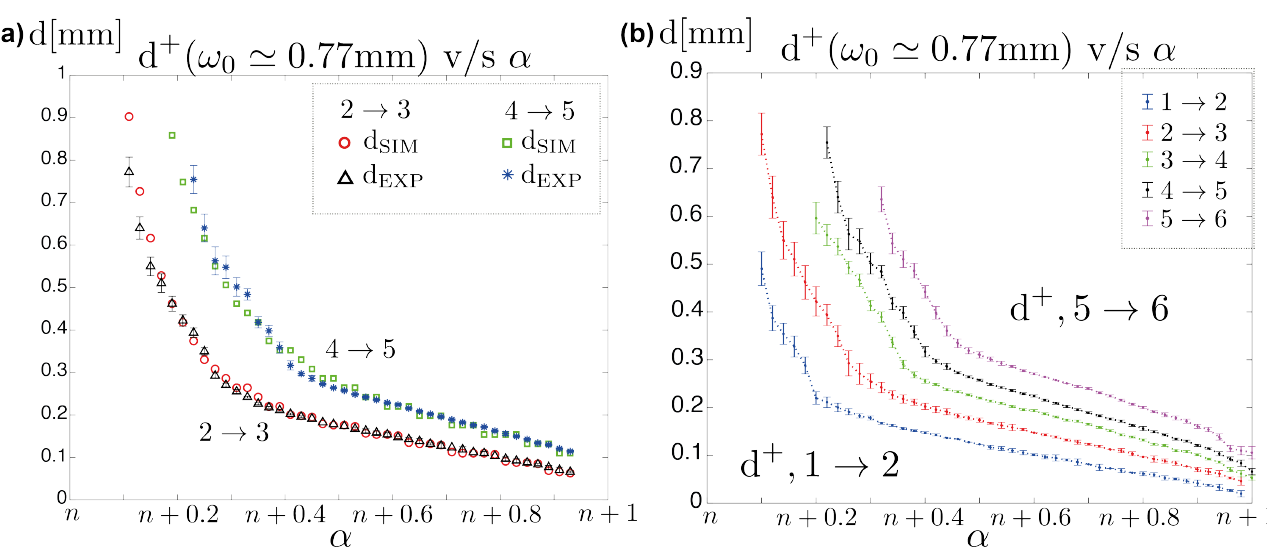
Figure 5. ( a ) Distances of resident vortices v r ( ω 0 = 0.77 mm, λ = 632.8 nm), for phase transitions 2 → 3 and 4 → 5. Numerical simulations (red circles for 2 → 3 and green square for 4 → 5) and experimental results (black triangles for 2 → 3 and blue asterisks for 4 → 5) comparison. ( b ) Experimental results: distances of resident vortices for transitions 1 → 2, 2 → 3, 3 → 4, 4 → 5, and 5 → 6 with α steps of